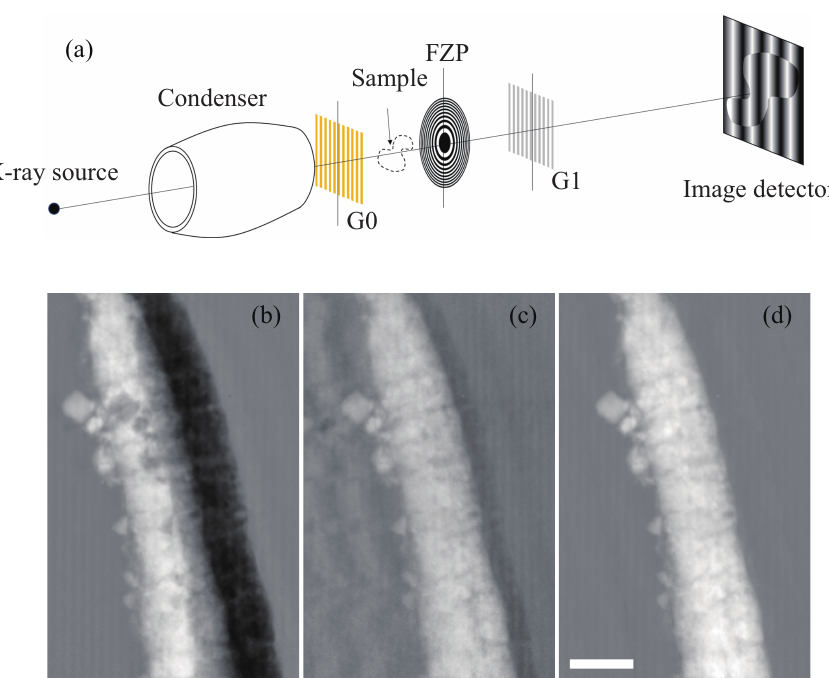
Figure 10. Optical configuration of the X-ray phase microscope ( a ) and the images of a larval Ciona robusta [77]: ( b ) Twin phase image, ( c ) phase image by simple deconvolution, and ( d ) phase image by iterative deconvolution algorithm. Scale bar: 10 µ